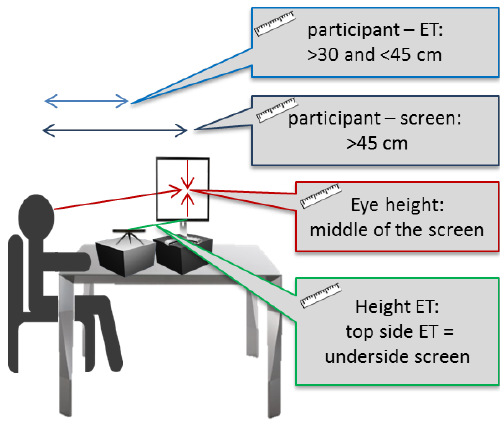
Figure 5: Best practices to set-up the Eye Tribe